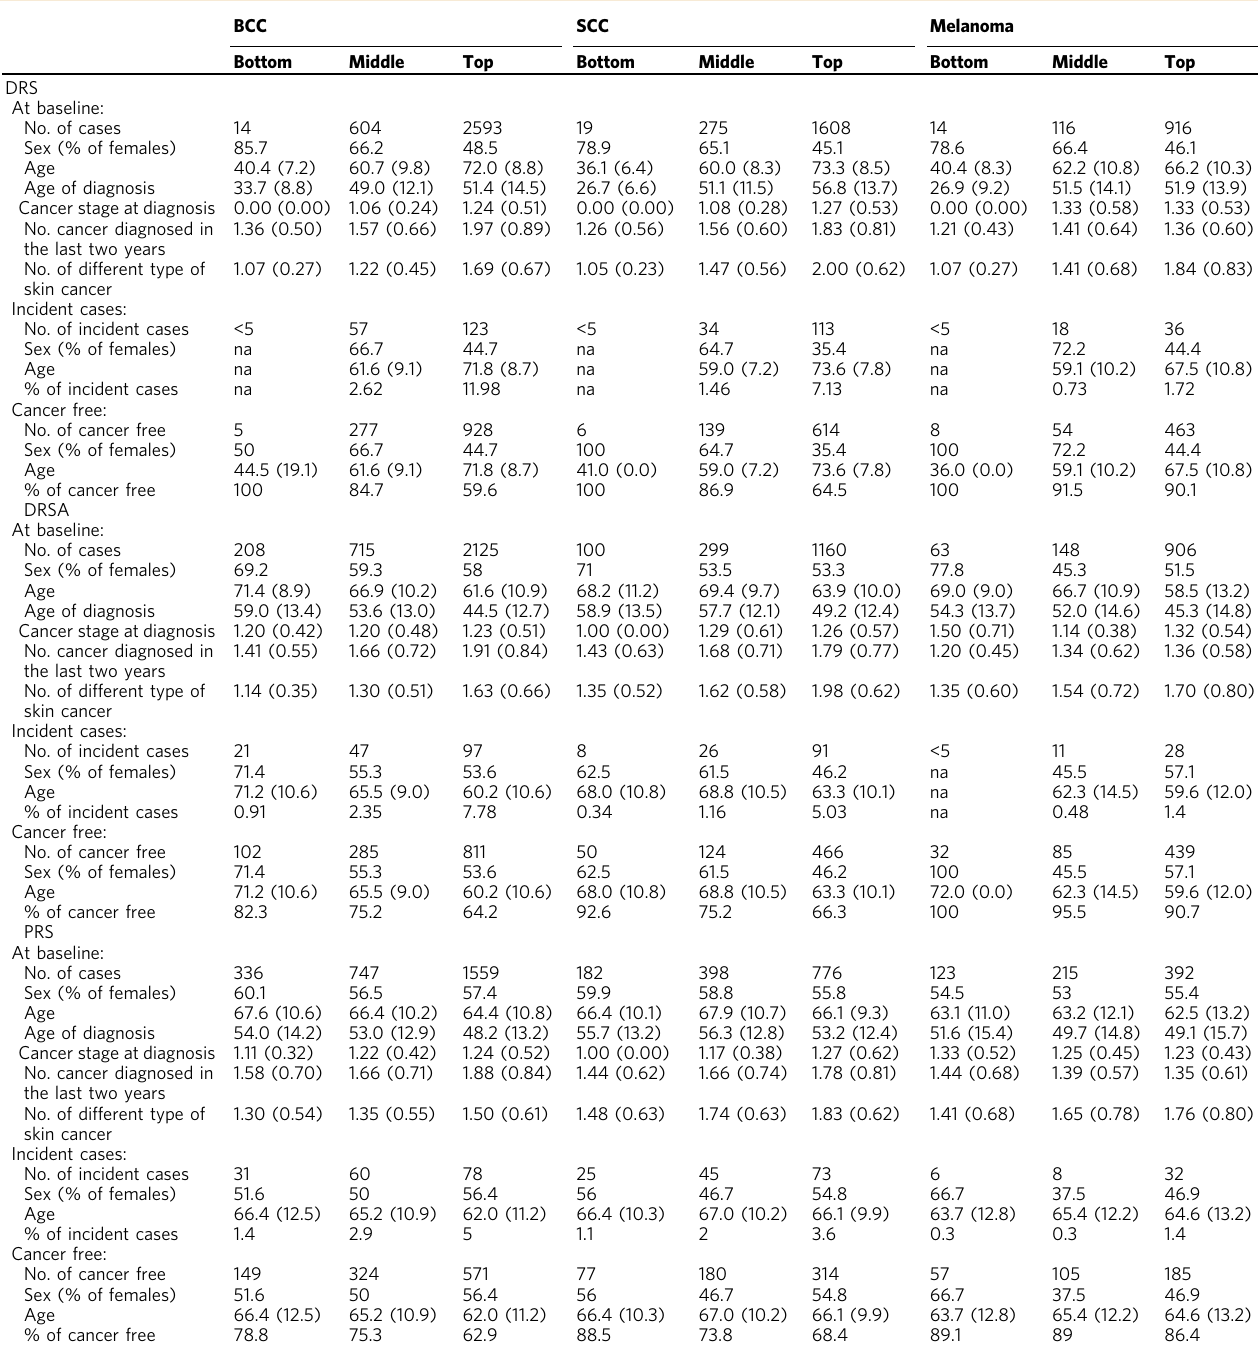
Mean and SD (within parenthesis) are shown for the disease characteristics. Statistics for categories with counts <5 are masked (na) to avoid risk of participant re-identi fi cation. No.